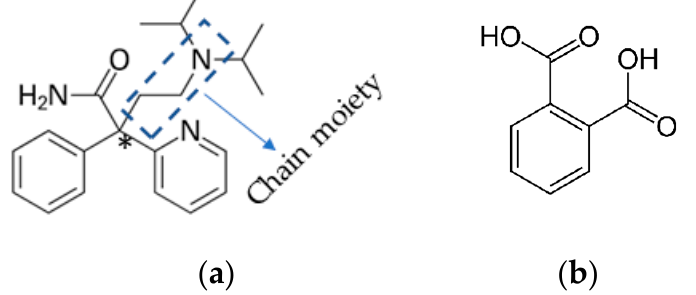
Figure 1. Structures of ( a ) racemic disopyramide (DPA) and ( b ) phthalic acid (PA).